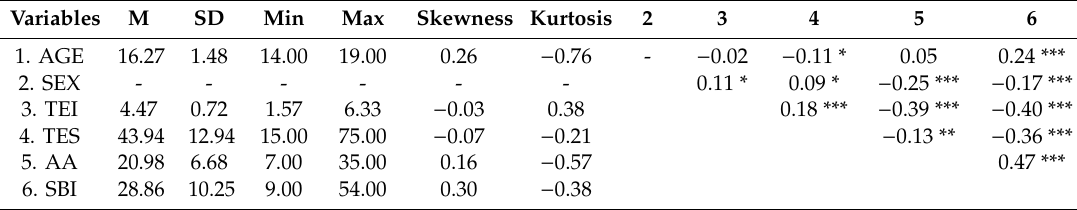
Table 1. Descriptive statistics and correlation matrix.